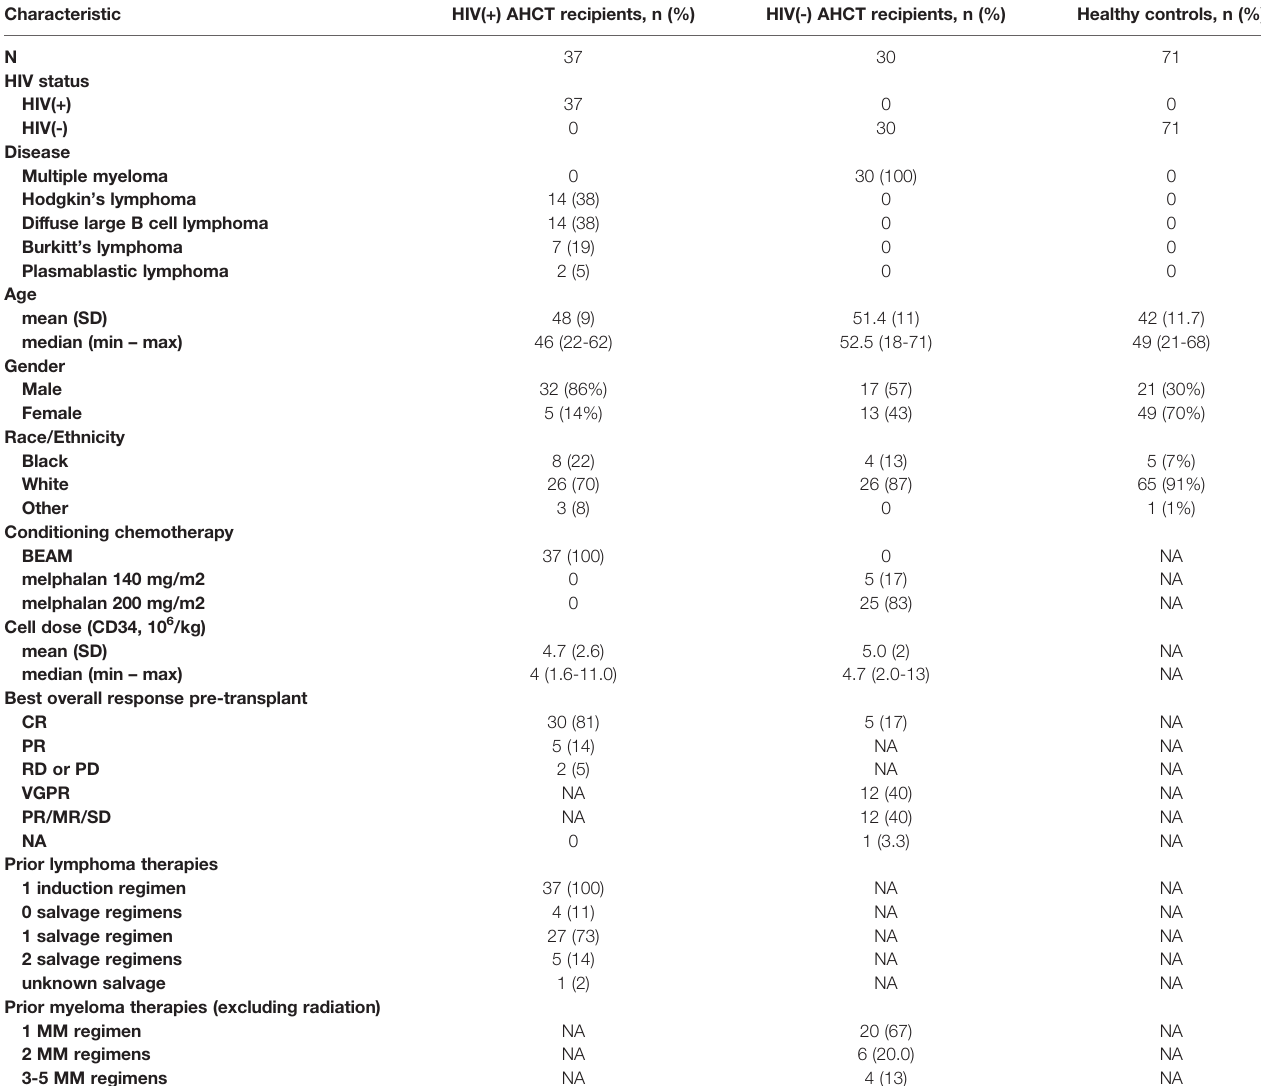
TABLE 1 | Demographic characteristics of the patient cohorts.